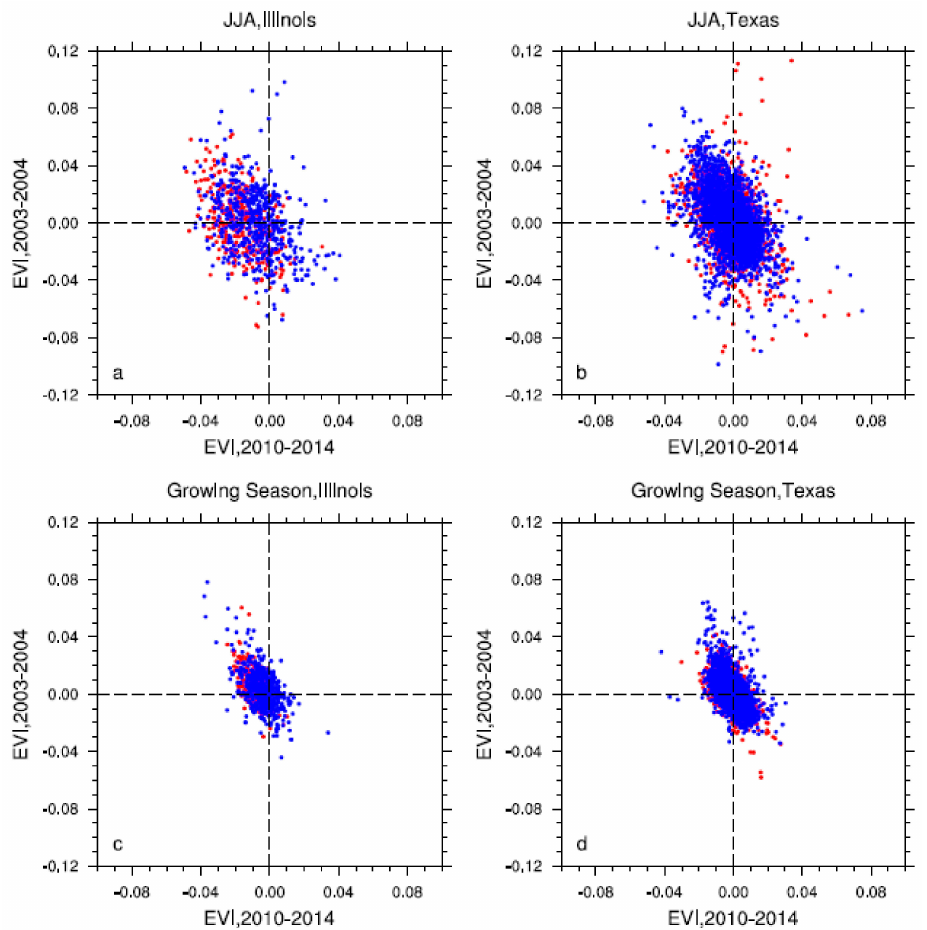
Figure 6. Scatter plots of EVI anomalies for the pre- (2003–2004) and post- (2010–2014) turbine periods: ( a ) JJA in Illinois, ( b ) JJA in Texas, ( c ) the growing season in Illinois, ( d ) the growing season in Texas. The red and blue dots represent WFPs and NWFPs,